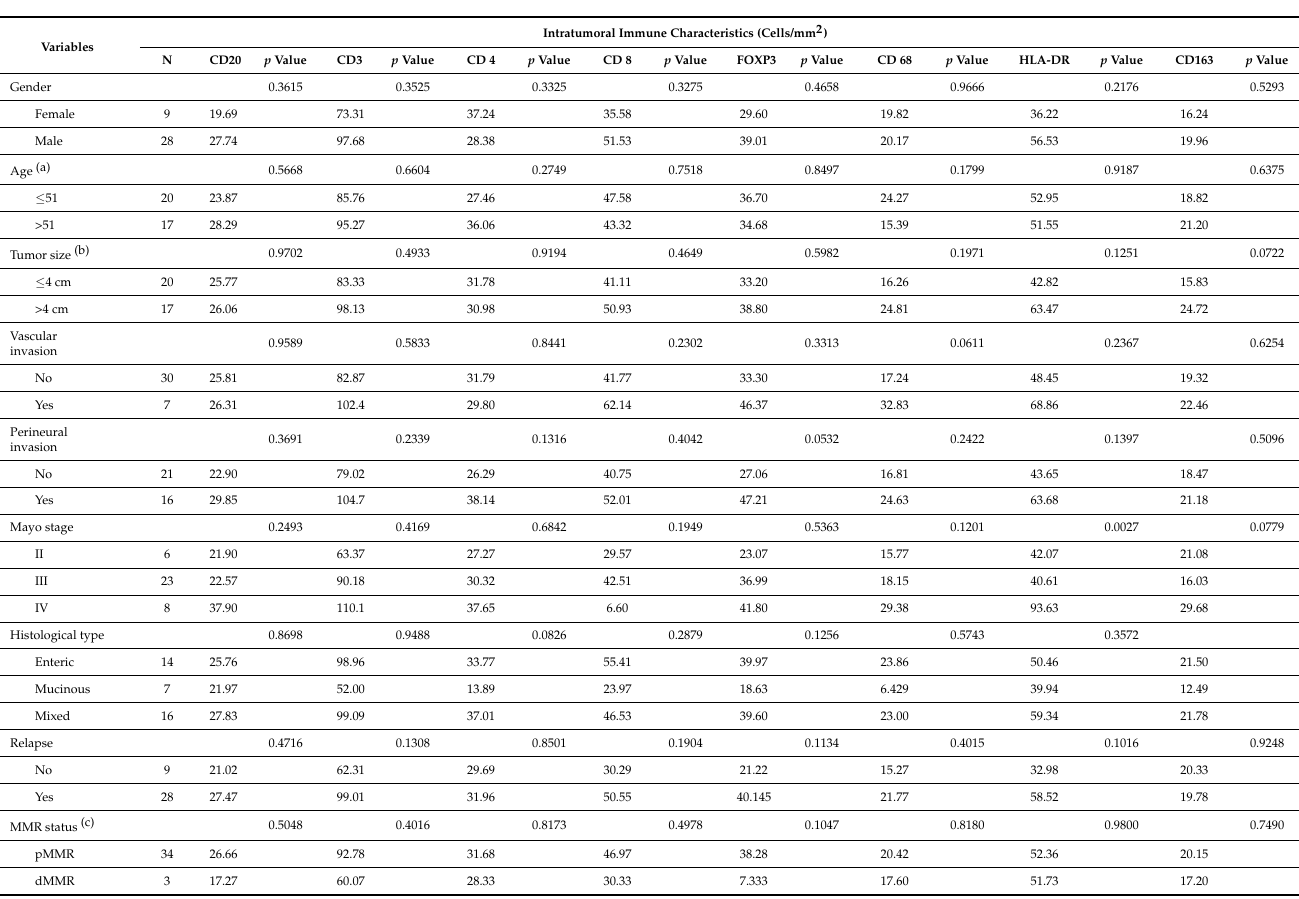
Table 1. Correlation between the intratumoral immune characteristics and clinicopathological vari- ables in UrC